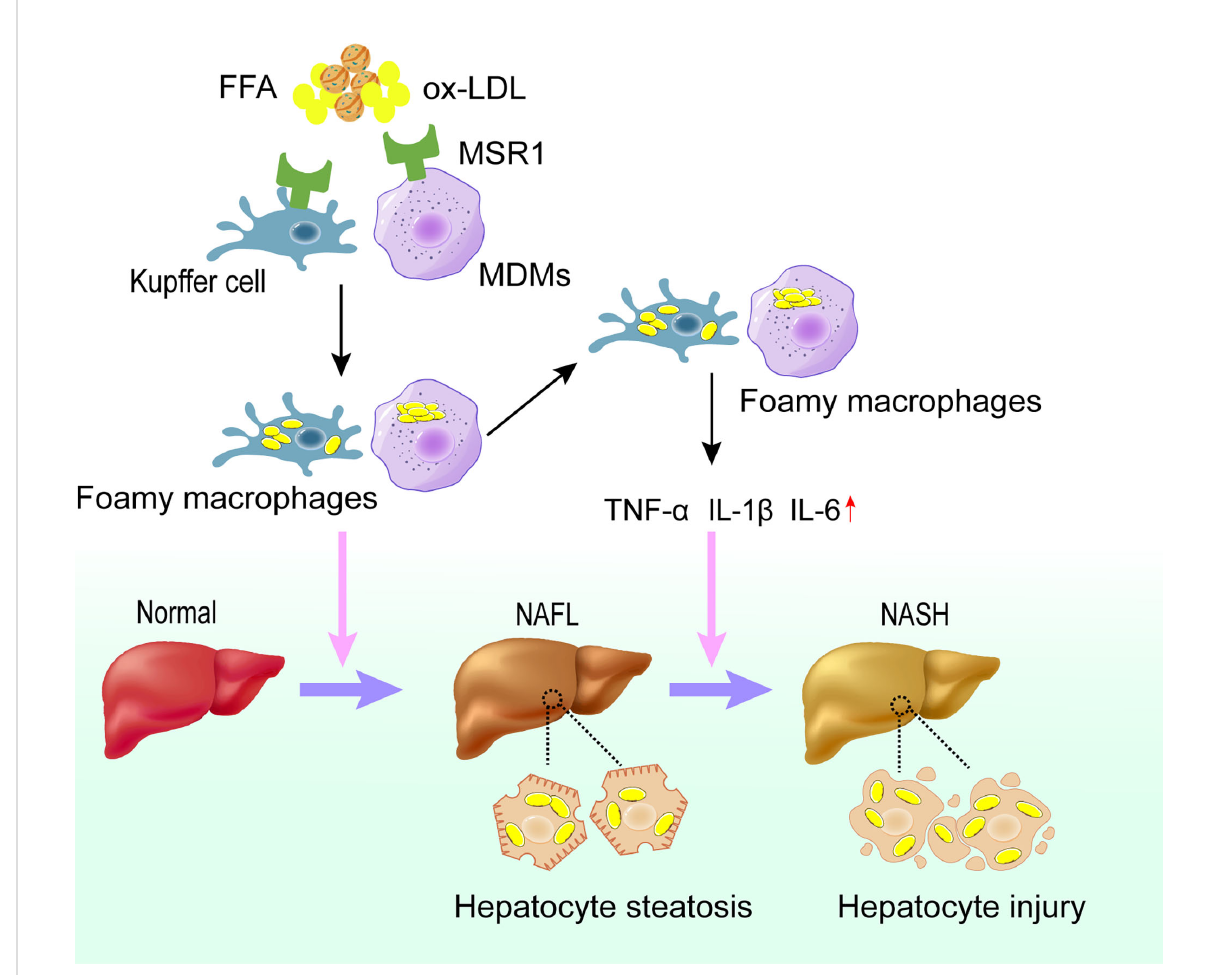
FIGURE 2 Role of MSR1 in NASH development and progression. In the early stage of NAFLD, dysregulated lipid metabolism promotes the expression of MSR1 in Kupffer cells and MDMs. MSR1 is responsible for the uptake of modi fi ed lipoprotein, leading to the formation offoamy macrophages and lipid accumulation in the liver. Meanwhile, foamy macrophages can promote the release of in fl ammatory factors and aggravate the injury of hepatocytes, thus promoting the progression of NASH. NAFL, simple steatosis; NASH, nonalcoholic steatohepatitis; MDMs, monocyte-derived